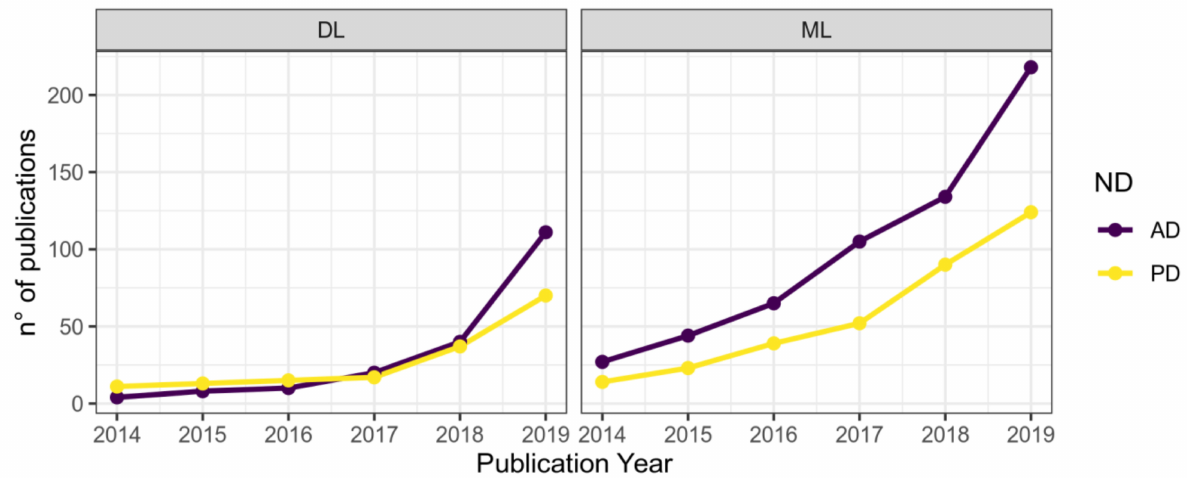
Figure 2. Number of publications in ML or DL fields by year and ND. Data were retrieved on dimensions.ai using Alzheimer’s or Parkinson’s diseases and deep learning or machine learning as keywords to search in title and abstract. Results were limited to “article” as Publication